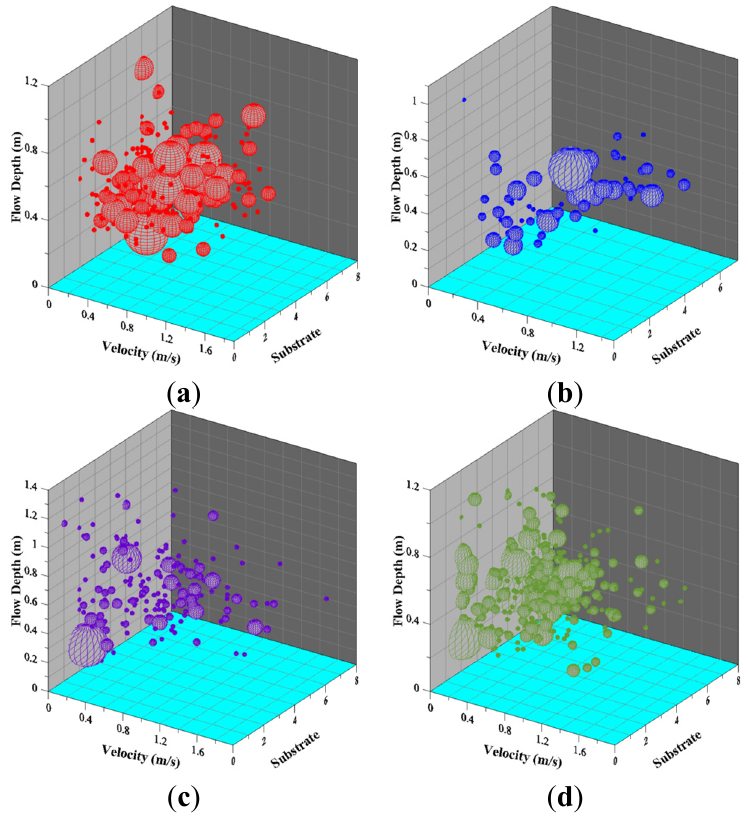
Figure 3. Observed distribution of Zacco platypus against velocity, flow depth, and substrate for ( a ) Dal River; ( b ) Hongcheon River; ( c ) Geum River; ( d ) Chogang